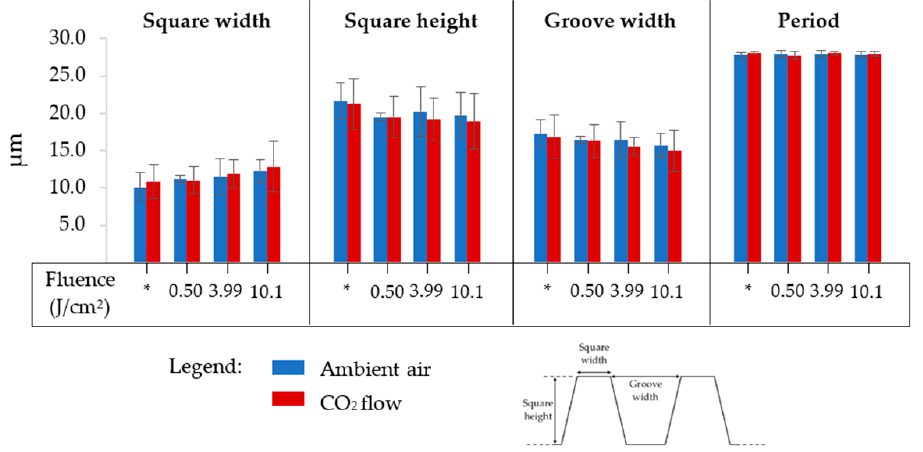
Figure 7. Dimensions of the micrometric square pillars designed on 316L SS for all the samples textured in ambient air or under a CO 2 flow with irradiation of their tops at different fluences; * = samples for which the square pillars’ top was not irradiated. The arithmetic mean roughness, Ra, was calculated by extracting profiles from a selected area from the interferometric images (Figure 8). This area was chosen to be the top of the micrometric square pillars to limit the distorted values that could be obtained because of the high number of non-measured points on the slopes of the squares. Filtering was not applied. An example of the series of profiles obtained is provided in Figure 9.